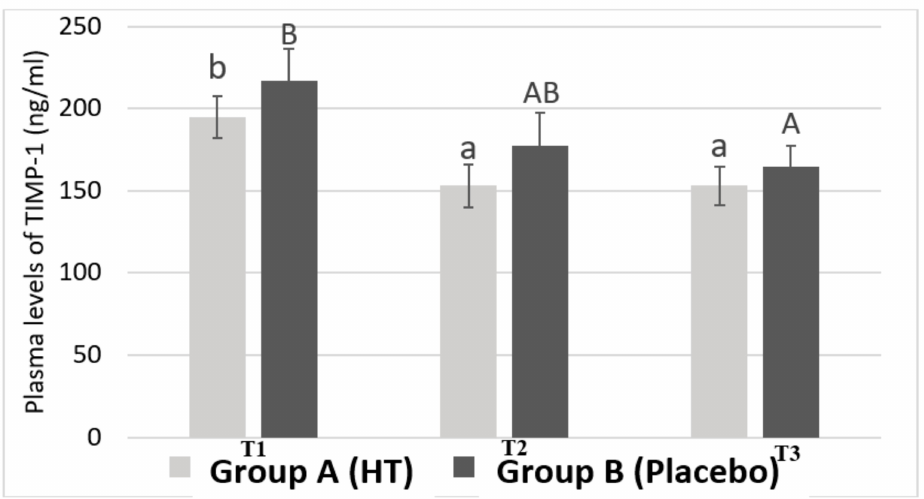
Figure 3. Plasma levels of the tissue inhibitor of metalloproteinases I (TIMP-1) in women with breast cancer. Values are shown as the mean ± standard error of the mean. Bars not sharing superscript letters are statistically di ff erent at p < 0.05 for each experimental group (lowercase for Group A treated with hydroxytyrosol and uppercase for Group B treated with placebo) at each time point (TI, T2 and